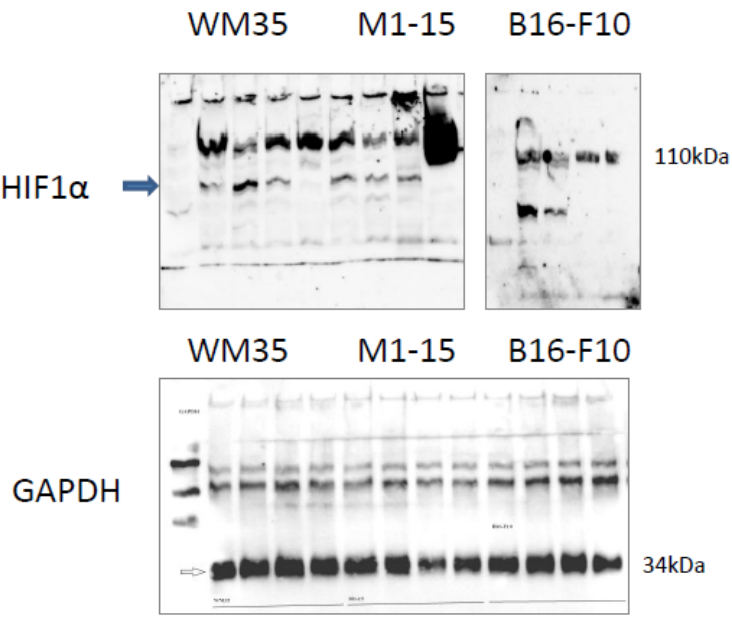
Figure A3. Original images WB Figure 7.